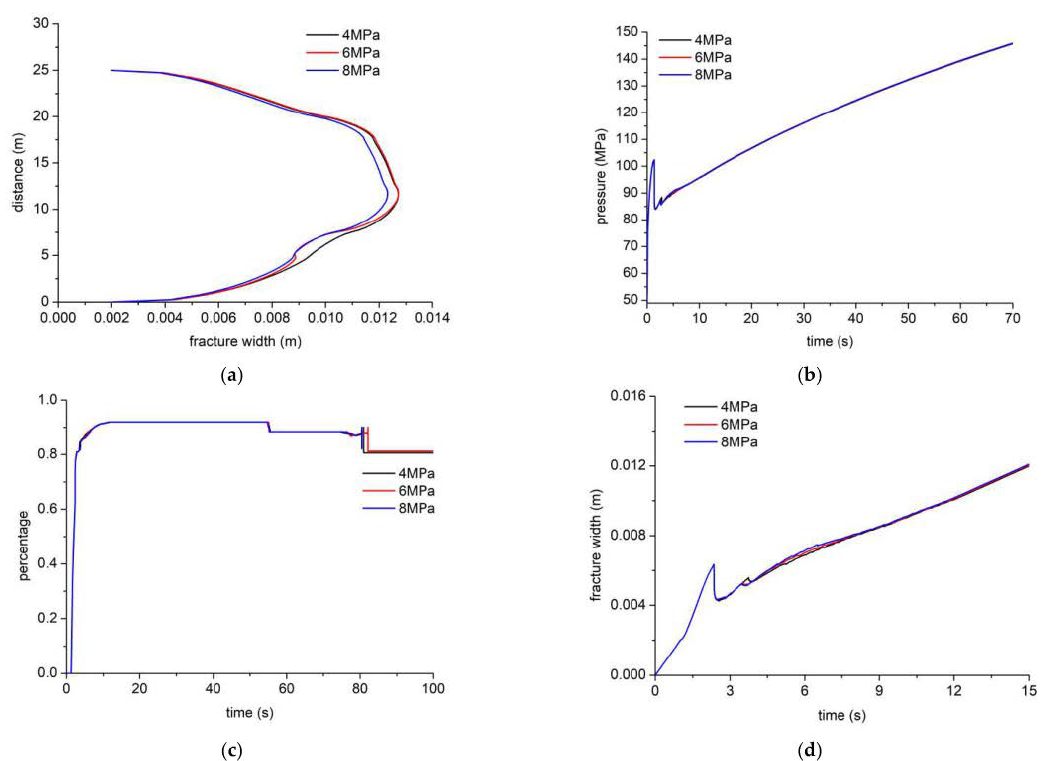
Figure 17. Fracture parameter under different stress contrast levels: ( a ) HF width; ( b ) pressure; ( c ) ratio of tensile failure; and ( d ) maximum HF width.